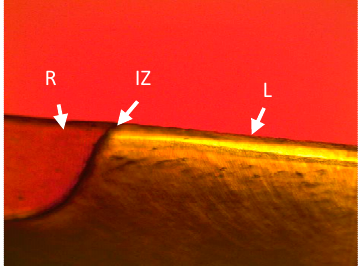
Figure 3. Tetric Evoceram Bulk Fill in dentin at 10 times magnification (R—restoration, L—lesion, IZ—inhibition zone).